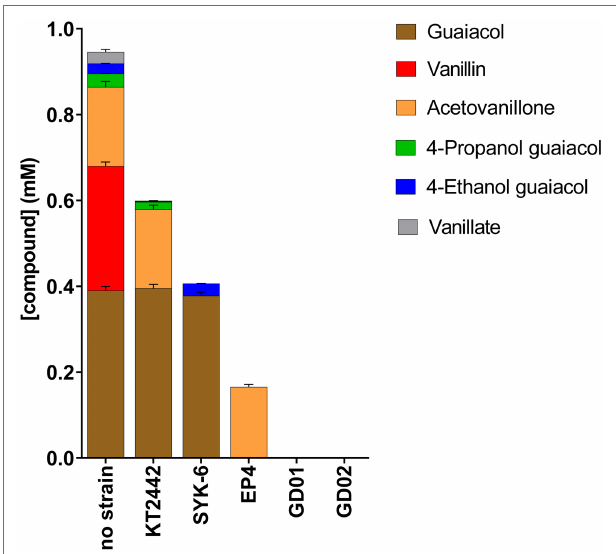
FIGURE 4 | Depletion of black liquor aromatic compounds by bacterial strains. Strains were incubated for 72 h on minimal medium amended with BL extract for a final concentration of 1 mM total monoaromatic compounds. Compounds were quantified using